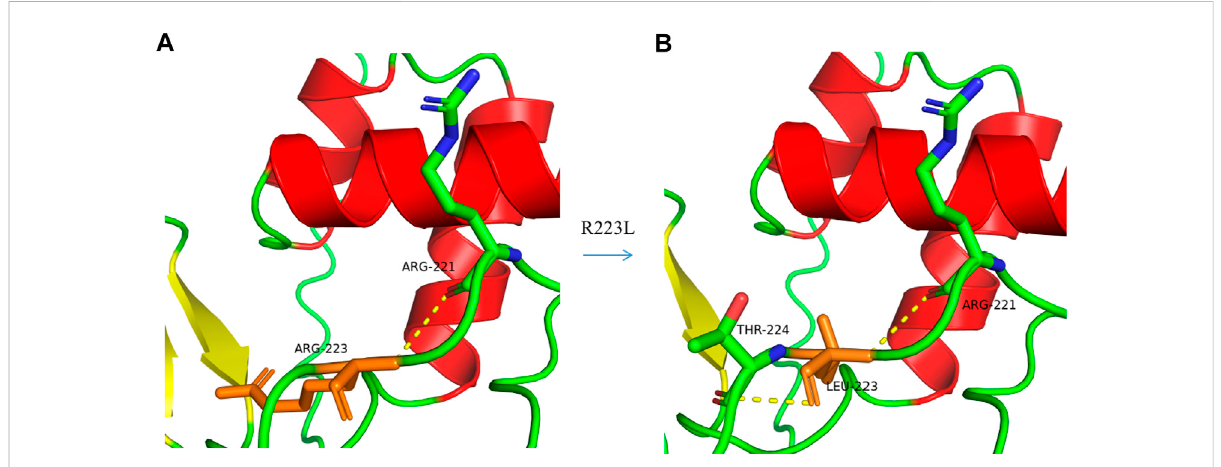
FIGURE 4 A 3-D model construction showed that the novel missense variation of c .668G > Tin PAX3 resulted in a large and positively charged amino acid of Arginine (R) at codon 223 being replaced by small and uncharged nonpolar amino acid of Leucine (L). The wild-type Arginine formed a hydrogen